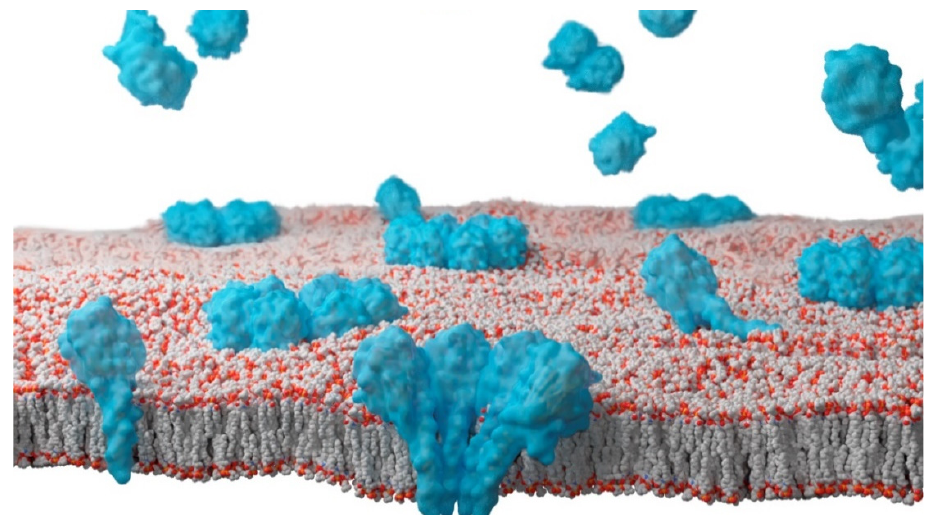
Figure 1. Artistic rendering of the process of pore formation by sticholysins. Lipids in grey (carbon atoms), red (oxygen atoms), and orange (phosphorus atoms). Actinoporins in light blue. Water-soluble monomers, and possibly dimers, (top, with no contact with the membrane) [14,24,48,49] would bind the membrane as monomers or higher-order oligomers. The helix would then be extended and deployed, lying on the membrane surface. Then, it would penetrate the bilayer, disrupting membrane continuity. The order in which all these steps take place, the stoichiometry of the different intermediates, and the existence, or not, of prepore complexes, is still matter of discussion. Finally, the thermodynamically stable pore complexes would assemble into octameric pores (at the front of the figure it is shown a cross-section of a final pore to illustrate its inner arrangement). This figure was generated using UCSF Chimera, UCSF ChimeraX (https://www.cgl.ucsf.edu/chimerax/docs/credits.html), and composed and rendered in Blender (Community, B. O. (2018). Blender—a 3D modelling and rendering package. Stichting Blender Foundation, Amsterdam. Retrieved from http://www.blender.org).